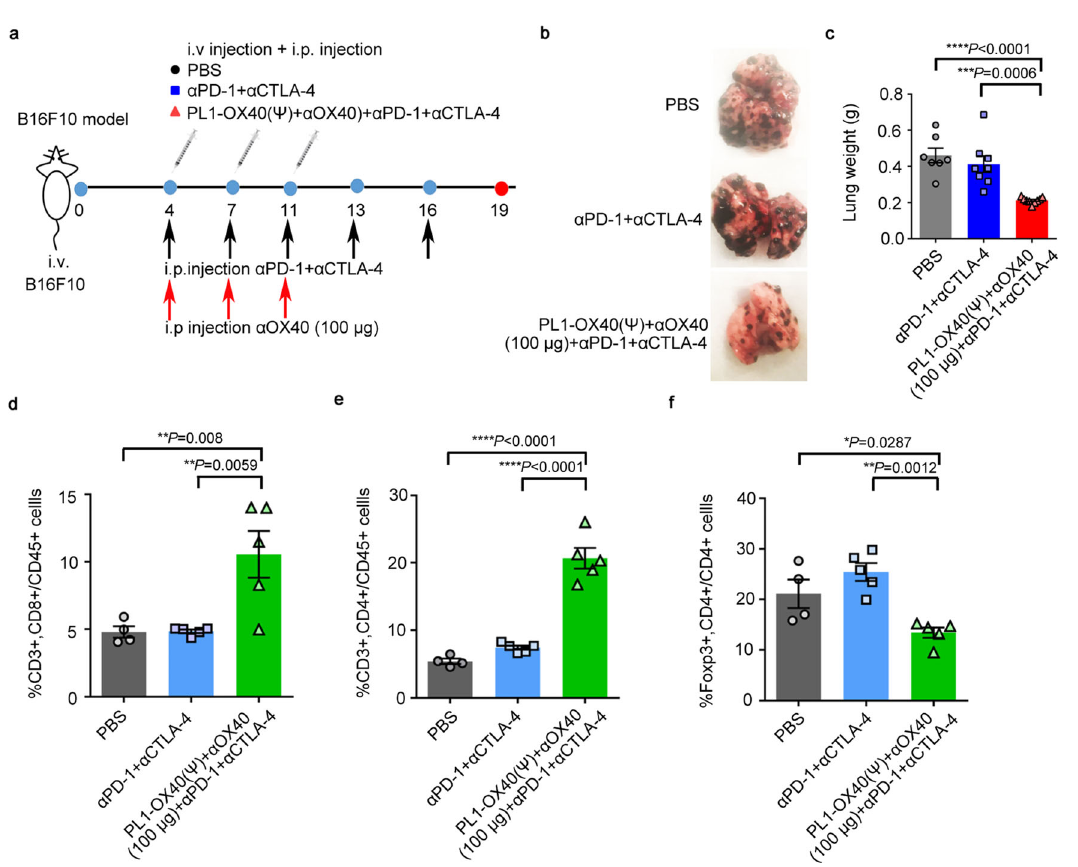
Fig. 5 Antitumor ef fi cacy in a lung metastasis mouse model. a Schematic illustration of lung metastases tumor of B16F10 cells with the treatment of PBS, anti-PD-1 + anti-CTLA-4 Abs, or PL1-OX40 mRNA + anti-OX40 Ab + anti-PD-1 + anti-CTLA-4 Abs. Mice received i.p. injections of PBS ( n = 7), i.p. injections of anti-PD-1 (100 µ g) + anti-CTLA-4 (100 µ g) Abs ( n = 8), or i.v. injections of PL1-OX40 ( ψ ) + i.p. injections of anti-OX40 (100 µ g) Ab + anti- (Supplementary Fig. 22 for all lung samples in three groups). c Lung weight. d – f Immune cell analysis of CD8 + T cells, CD4 + T cells, Foxp3 + CD4 + (Treg) cells in the lungs from different treatments ( n = 4, 5, 5), respectively. Data in c – f are presented as the mean ± S.E.M. Statistical signi fi cance in c – f was analyzed using one-way ANOVA followed by Dunnett ’ s multiple comparison test. * P < 0.05; ** P < 0.01; *** P < 0.001; **** P < 0.0001. Source data are provided as a Source Data fi